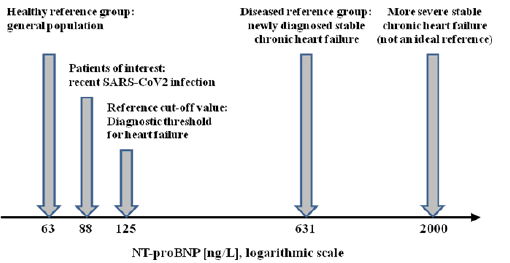
Figure 1. Schematic plot of the relevant NT-proBNP values for example 1. Example